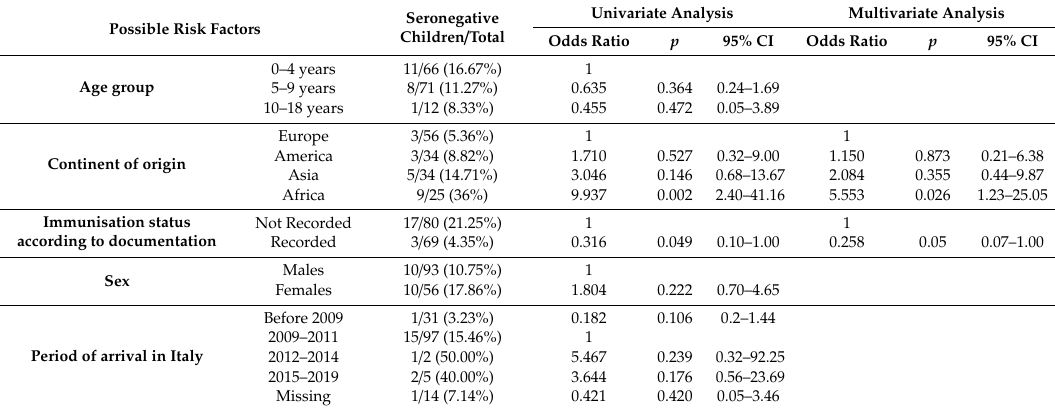
Table A9. Univariate and multivariate analyses for factors associated seronegativity for diphtheria. Possible Risk